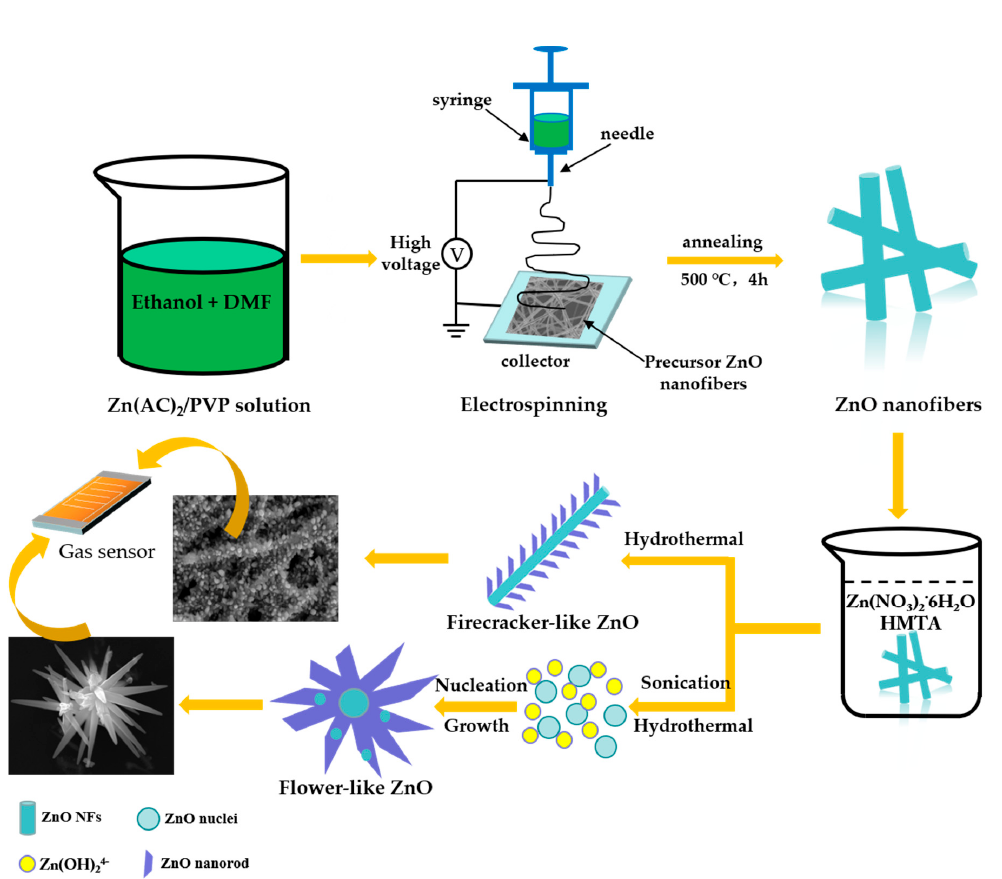
Figure 6. Schematic diagram of the formation of as-prepared firecracker-like ZnO (ZnO HS1) and flower-like ZnO (ZnO HS2) materials.